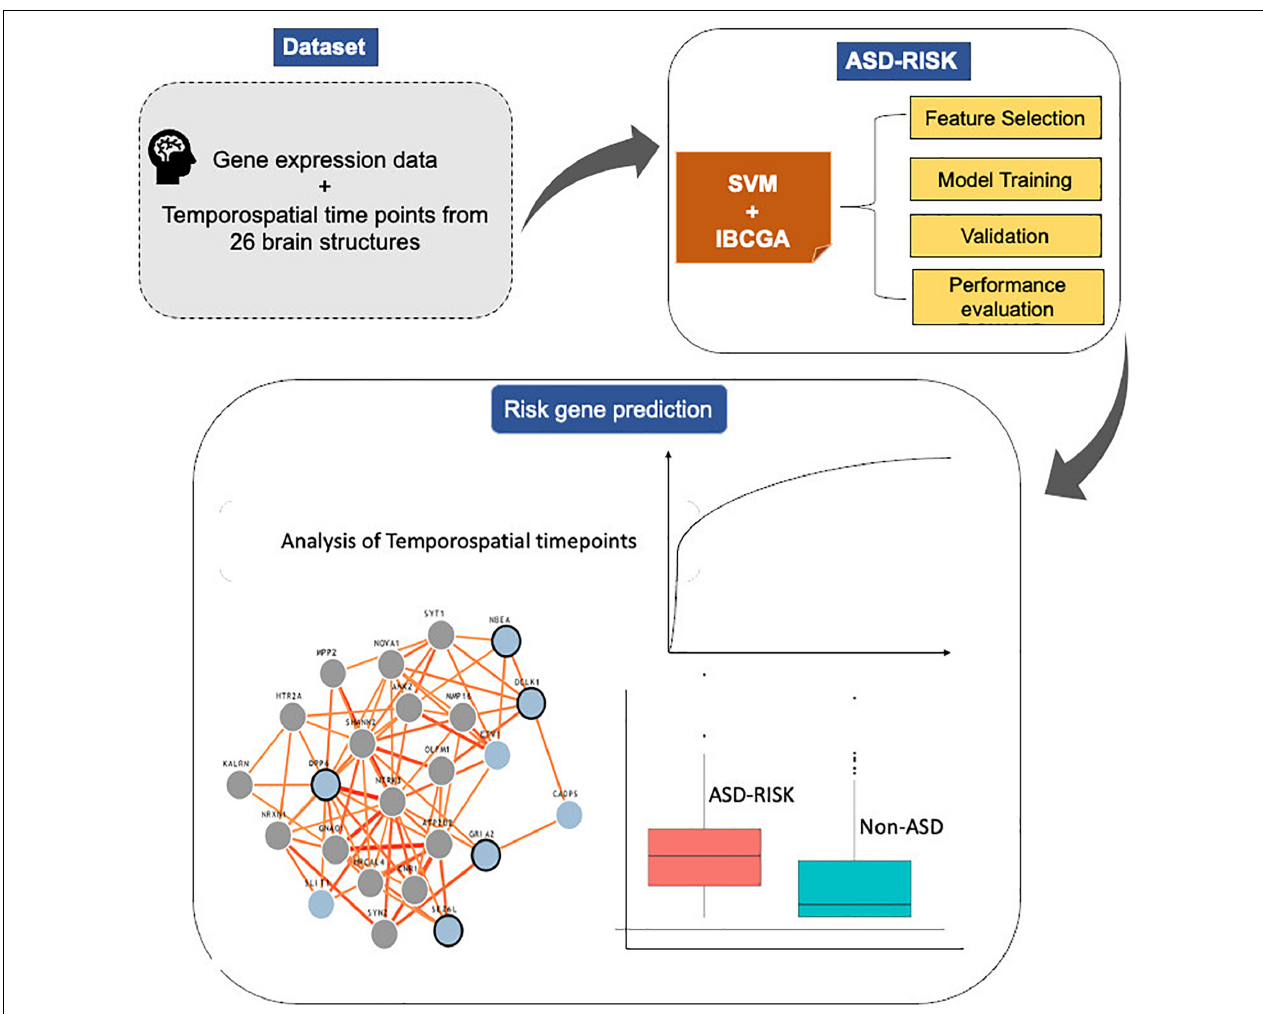
FIGURE 1 | System flowchart of the proposed